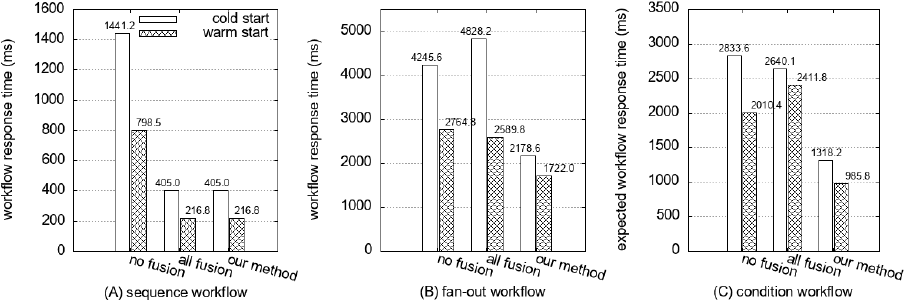
Figure 10. Workflow response time on the cold start and the warm start of the original workflow, all functions fused workflow, and workflow fused by our method (in example